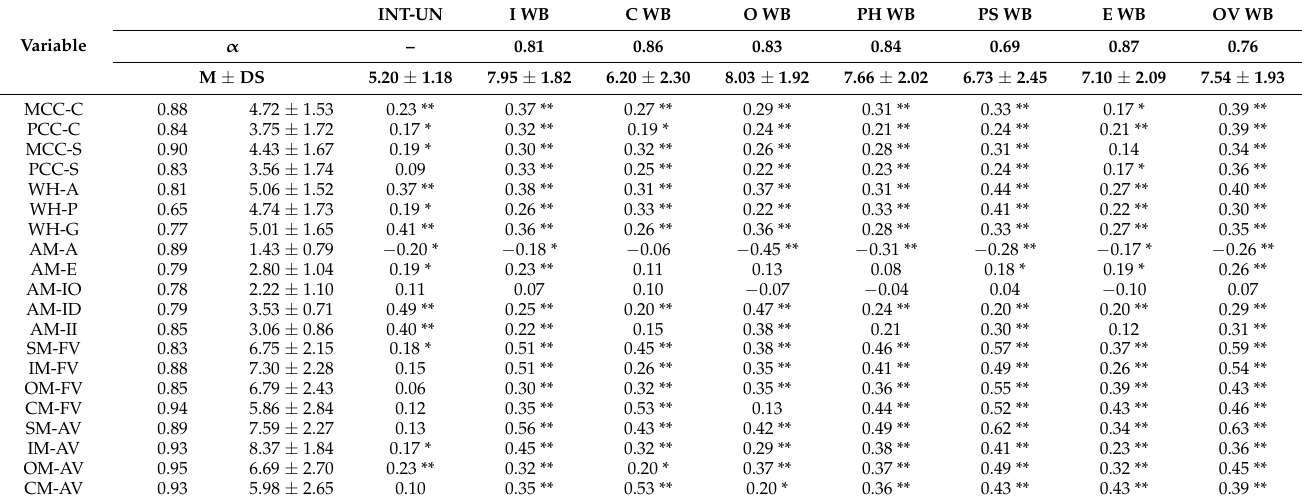
Table 2. Reliability indices, descriptive statistics, and correlations between hypothesised predictors and outcomes (N =